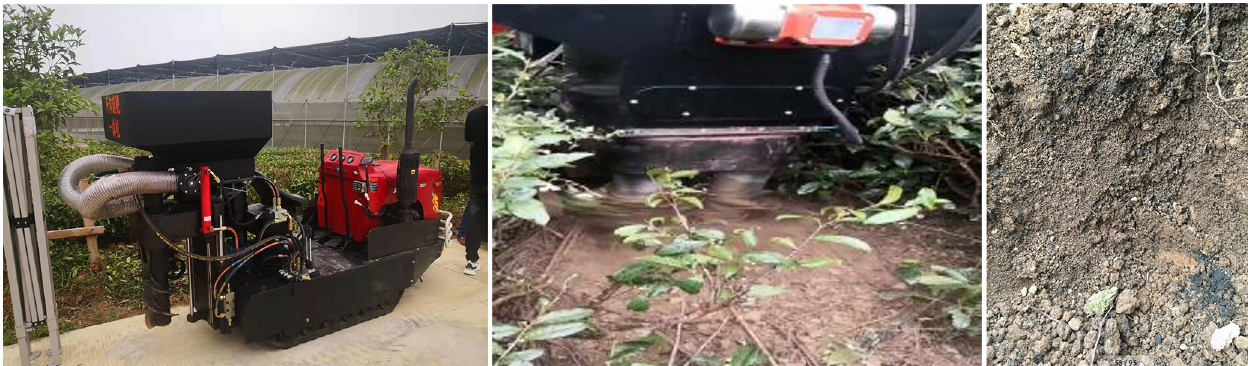
Fig 9. Performance test of the double screw trencher and